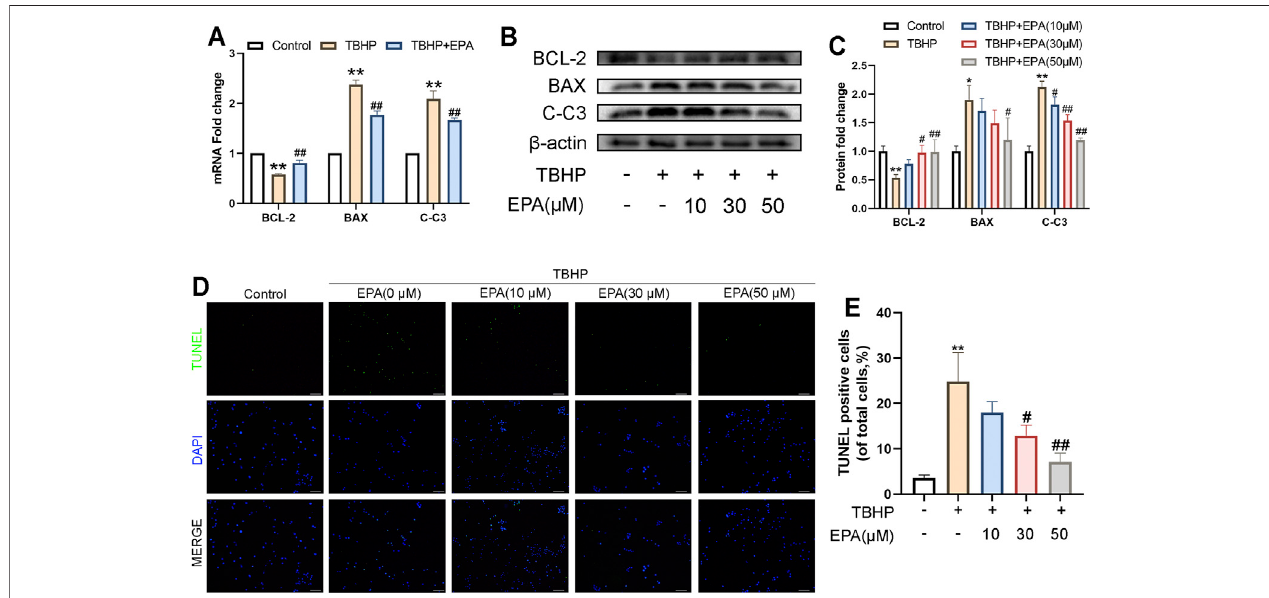
FIGURE2| TheeffectofEPAontheapoptosisofNPCsunderTBHPstimulation. (A) Thegeneexpressionofapoptosisfactors,suchasBCL-2,BAXandCleaved- caspase 3 (C-C3) were detected by qPCR in the NPCs, treated with or without the administration of EPA with TBHP for 24 h (B,C) The protein expression of BCL-2, BAX, and C-C3 detected by western blot in the NPCs. (D – F) Apoptotic chondrocytes were examined using TUNEL fl uorescence immunocytochemistry (green). Nuclei werecounterstainedwithDAPI(blue)(bar:100 μ m).Thevaluespresentedarethemeans ± SD( n (cid:2) 3).* p < 0.05,** p < 0.01,compared withthecontrolgroup;# p < 0.05, ## p < 0.01, compared with the TBHP treatment